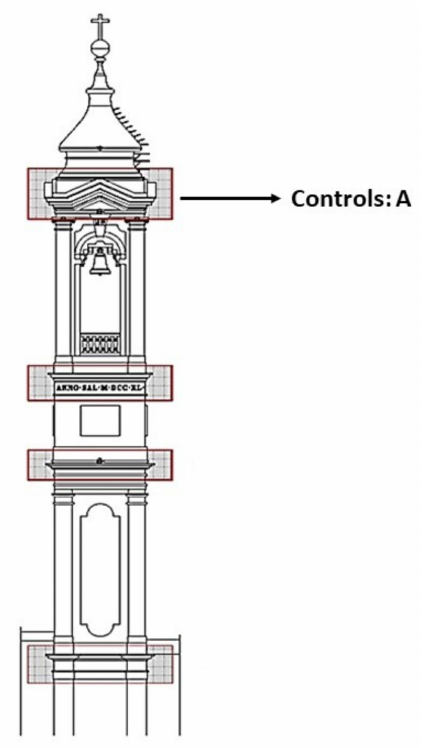
Figure 2. The bell tower of San Lorenzo and the corresponding sampling area, where a single block of Pietraforte was detached (which represented the control and the substrate from which all the samples used for the experimentation were